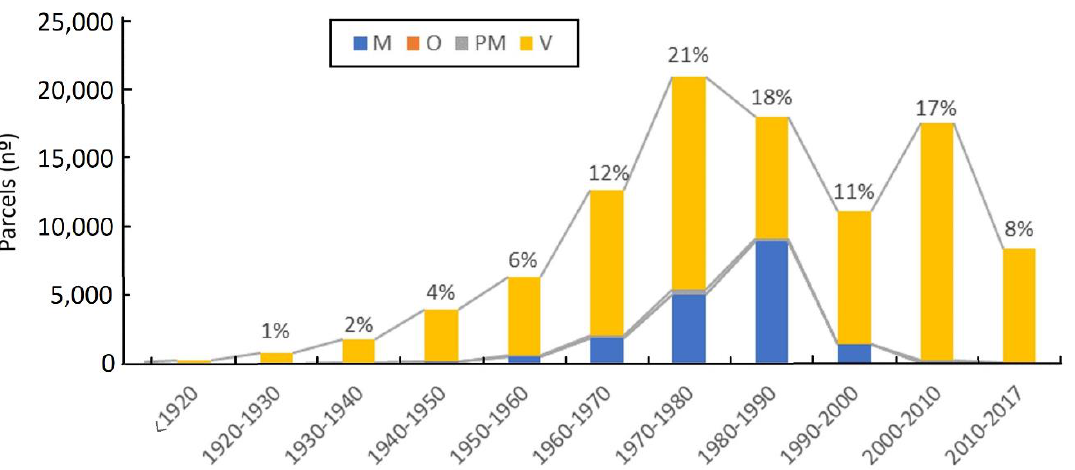
Figure 5. Time period of plantation (x-axis) and number of parcels planted in the region (y-axis, in hectares) according to each final product of wine.